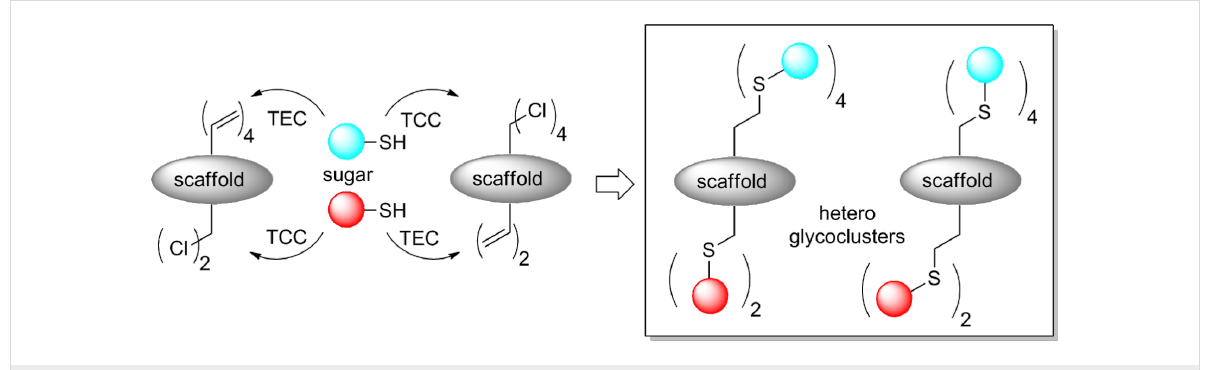
Figure 1: Chemical strategy for the construction of heteroglycoclusters.